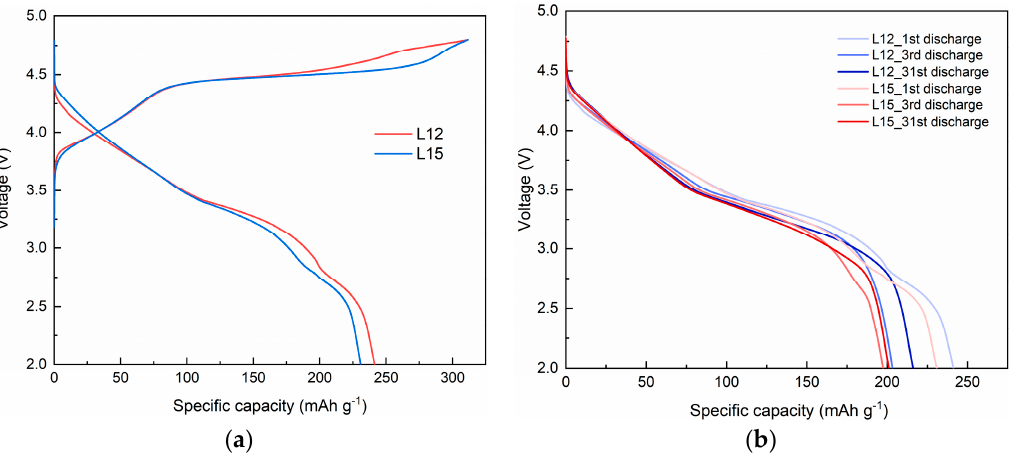
Figure 7. ( a ) Initial charge–discharge profiles of L12 and L15 at 0.03C within 2.0–4.8 V; ( b ) Voltage profiles of L12 and L15 for comparison of the 1st discharge, 3rd discharge and 31st discharge. Table 6. Initial charge–discharge performance of L12 and L15 at 0.03 C in the range of 2.0–4.8 V.